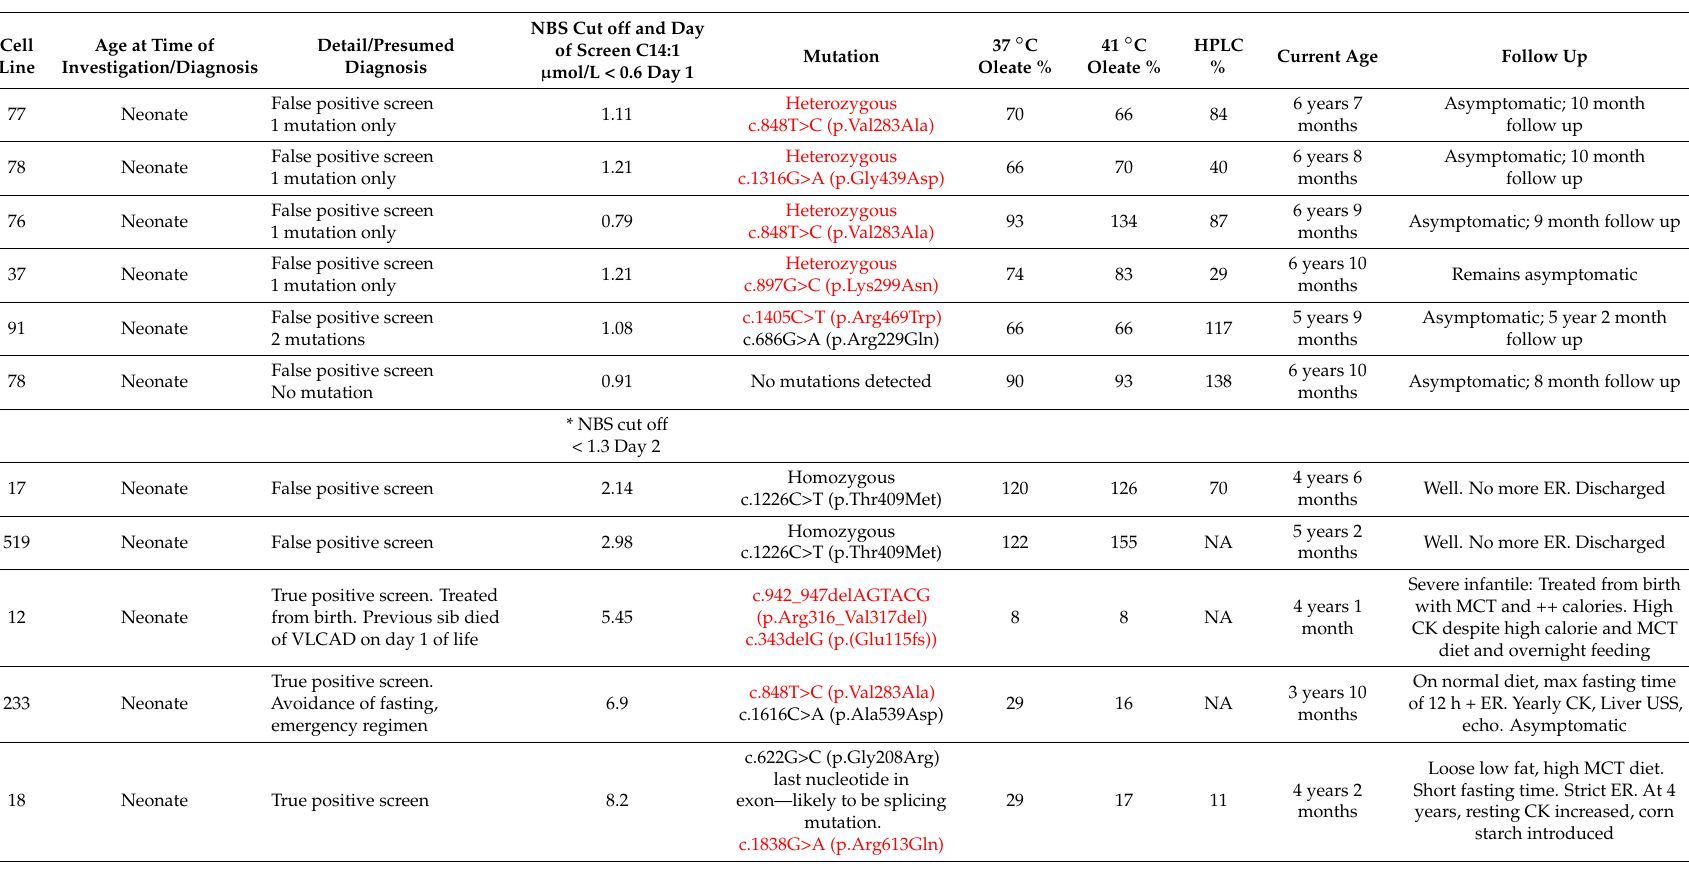
Table 1. Clinical and biochemical data from positive NBS patients, symptomatic adults and obligate